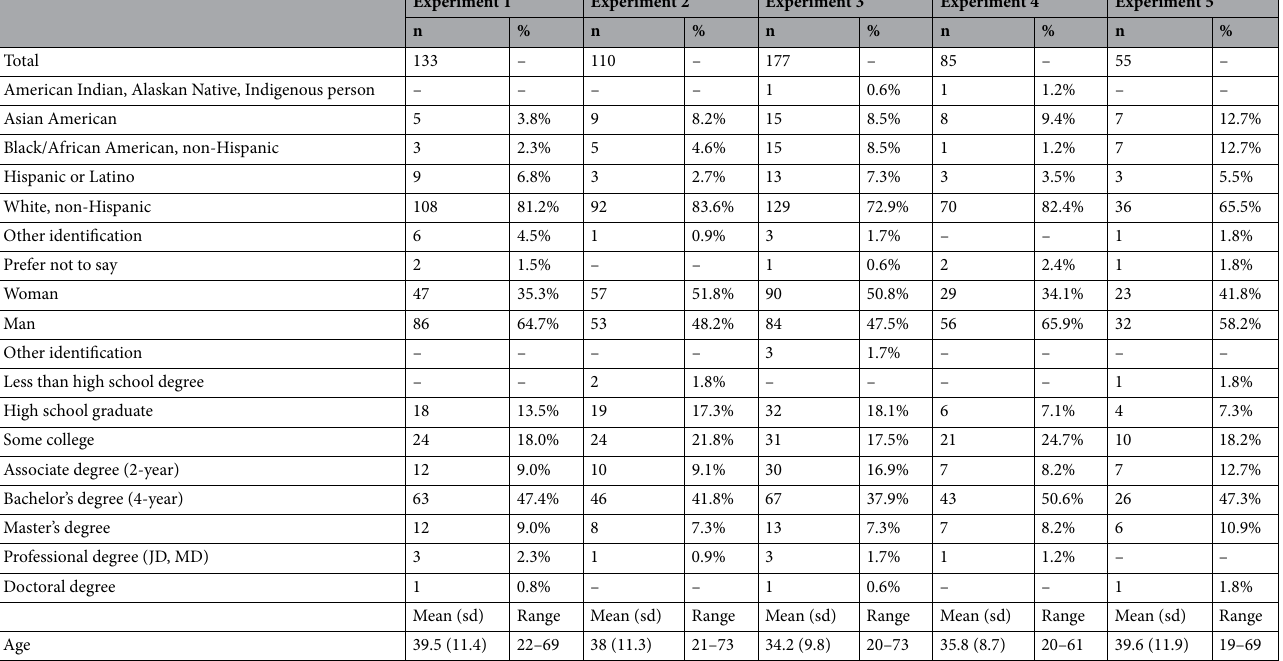
Table 2. Demographic characteristics of participants in Experiments